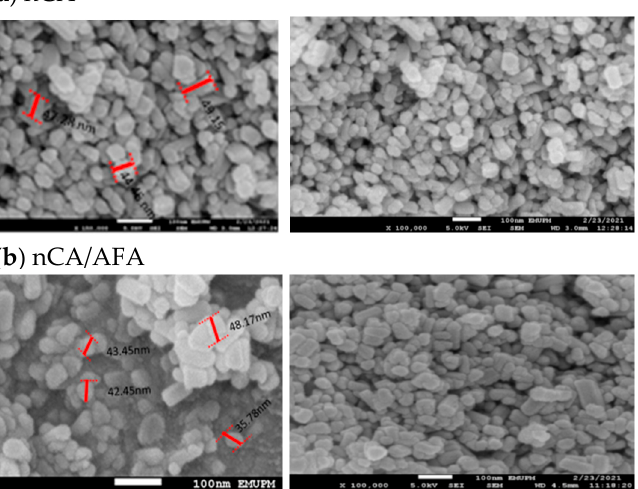
Figure 5. FESEM representative images of ( a ) nCa and ( b ) nCA/AFA, with a scale bar of 100 nm. The average length, according to FESEM, for the nCA was 49.98 ± 5.71 nm, and 22.65 ± 1.94 nm in width. Unchanged morphology for nCA/AFA could be noticed but with reduced length and width as a function of afatinib drug encapsulation, where the length was 42.47 ± 4.72 nm, and the width was 21.58 ± 1.77 nm.